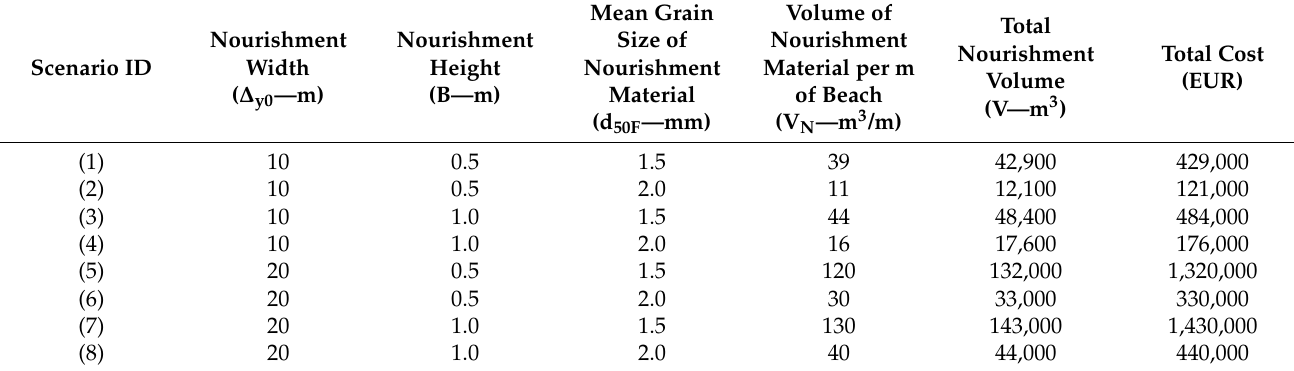
Table 3. Estimated volumes, filling costs of nourishment for Komi beach according to different